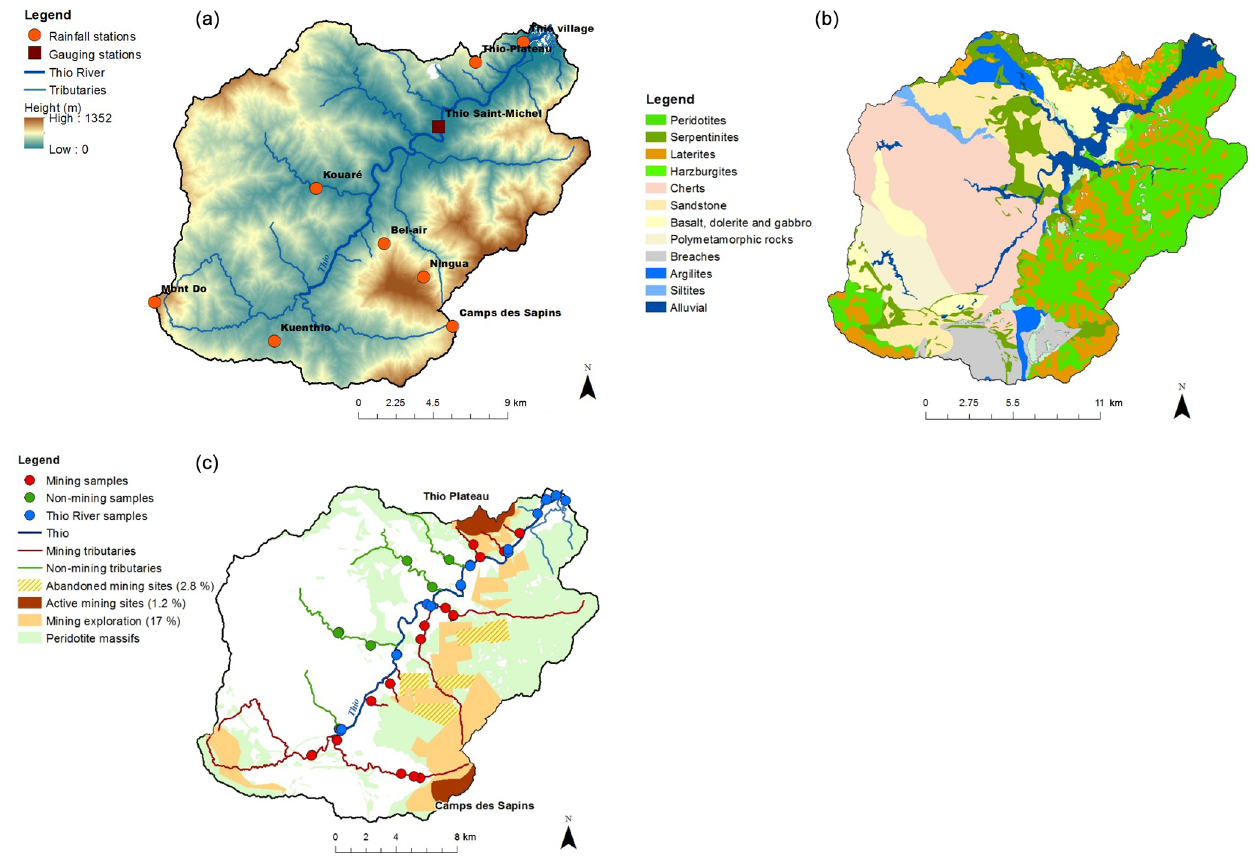
Figure 2. Location of the rainfall and river monitoring stations (a) , main lithologies (b) and location of the sediment samples collected along with tributary source classifications (c) conducted in the Thio River catchment, New